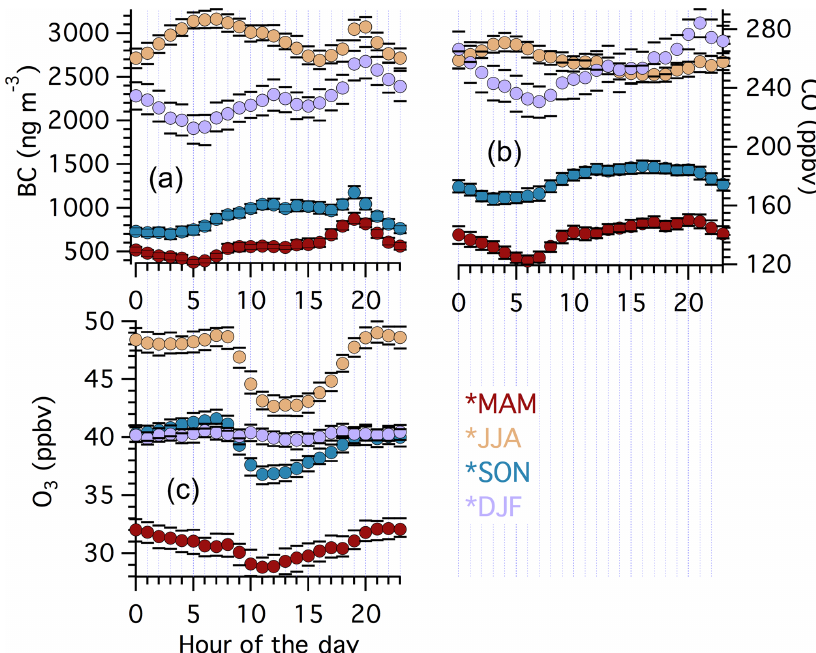
Figure 8. Seasonally separated diurnal profiles of (a) BC concentrations, (b) CO mixing ratios, and (c) O 3 mixing ratios, colored for each season. The circles represent mean concentrations, and the lines represent 95% confidence